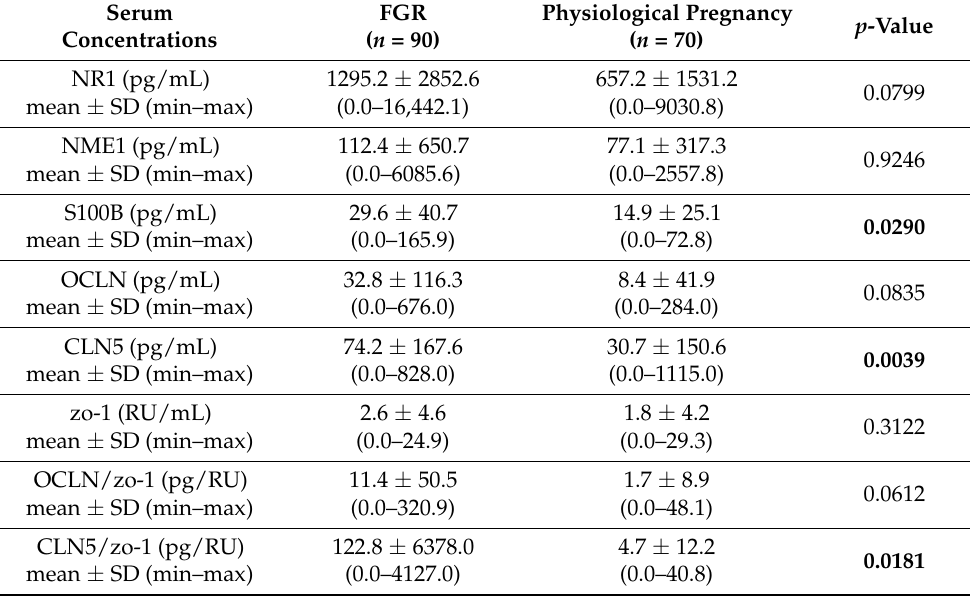
Table 3. Serum concentrations of biochemical parameters in pregnancies complicated by fetal growth restriction (FGR) and physiological pregnancy. The statistically significant differences between groups are highlighted in bold.